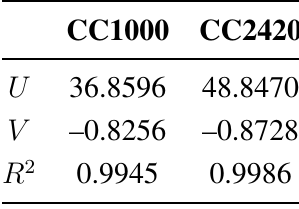
Table 1. Fitting of U radio